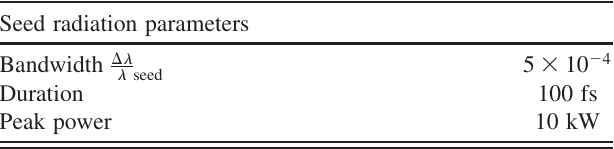
TABLE III. Seed radiation parameters for the HGHG